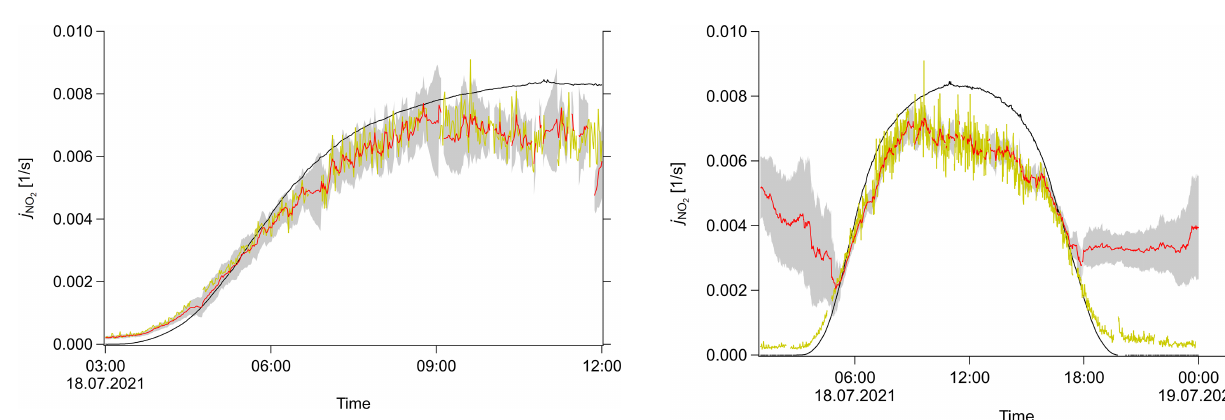
Figure 7. Variation of the free parameter σ 0 and its exemplary effect . σ 0 , rel is decreased by a factor of 3. Pho- on the inference of j NO 2 tolysis frequency j as a function of time (UTC) for an arbitrary day of the field campaign. Original measurement (black), PSS calcula- tion (yellow), SMC ensemble mean (red) and ± 1 σ interval (shaded gray